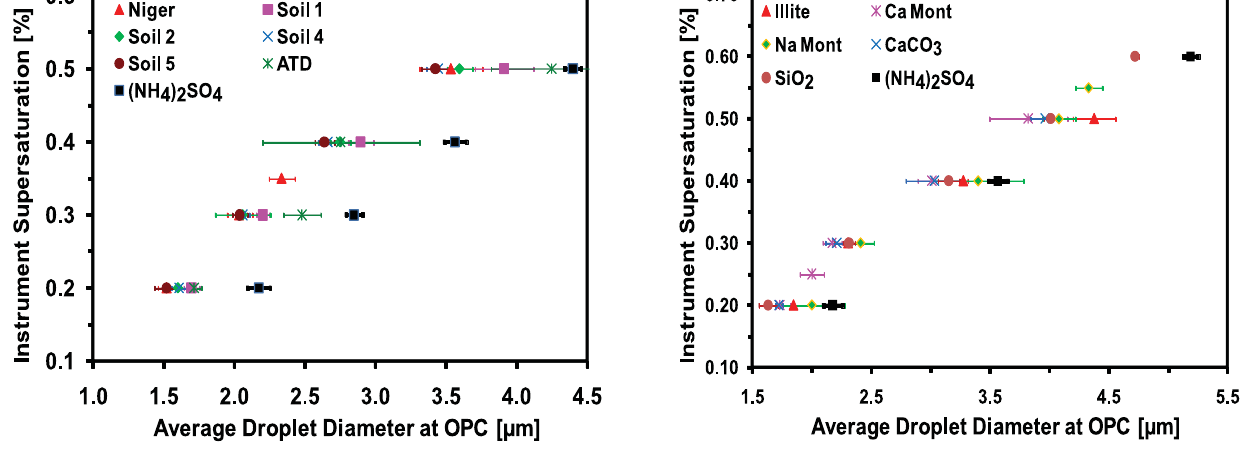
Fig. 8. Activated droplet sizes of mineral dust CCN with s c equal to the instrument supersaturation shown as symbols. Error bars rep- resent experimental uncertainty in droplet size as observed by the OPC at same instrument supersaturation.